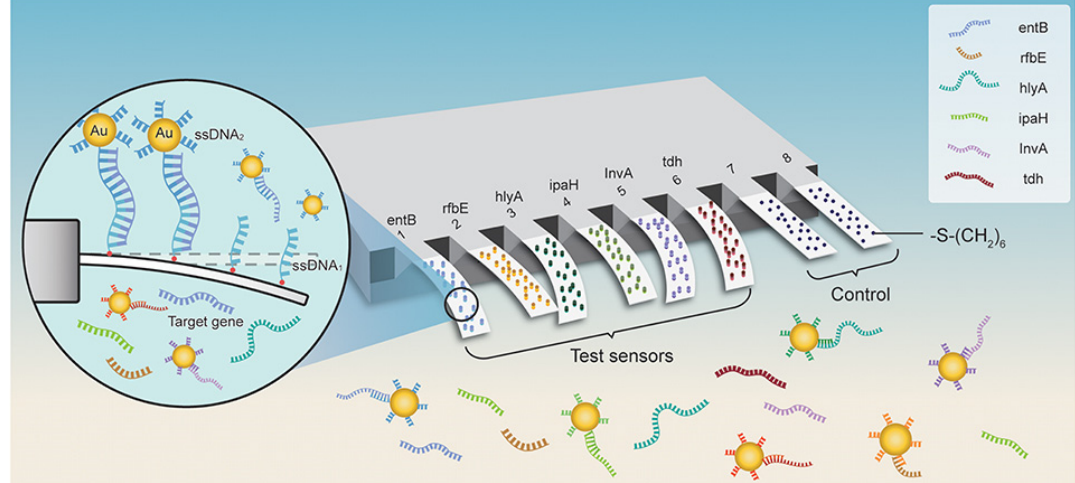
Figure 3. Schematic representation for microcantilever array biosensor modified with gold nano- particles for foodborne bacteria detection, adapted from [86] , Frontiers, 2019.